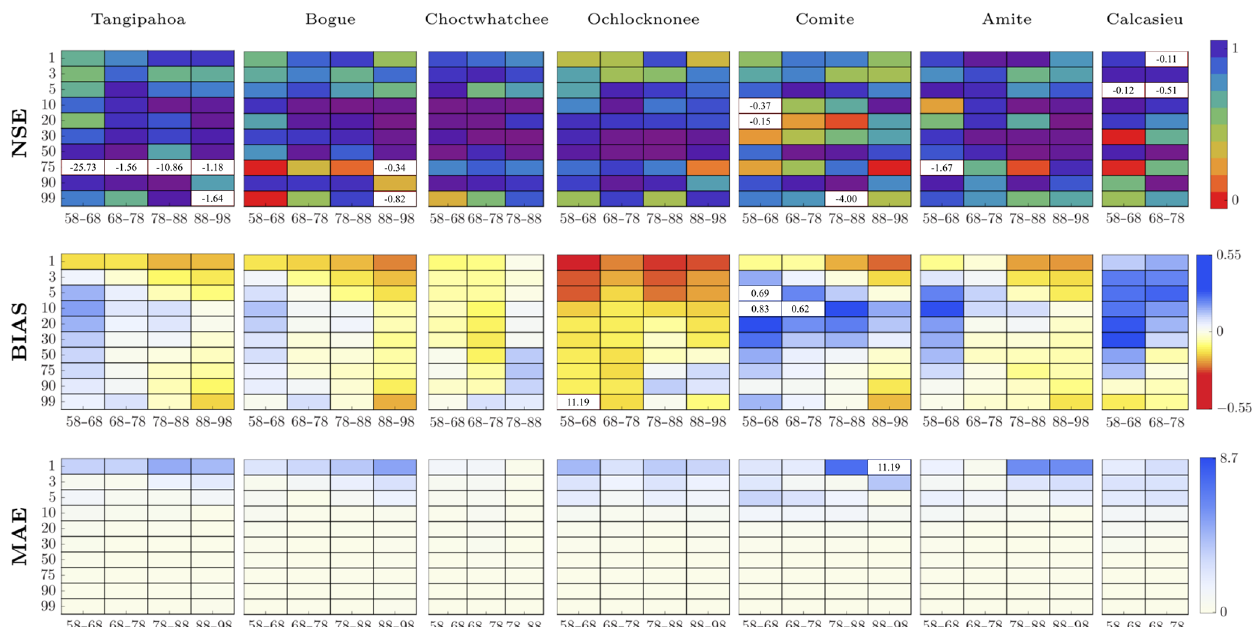
Figure 10. Performance measures NSE, BIAS and MAE evaluated for specific percentiles (on the y axis) and for specific target decades on the x axis. The donor decade is 1948–1958 and the donor basin is Blanco (TX). Each target basin is indicated in the corresponding box. Negative values of the NSE as well as outliers of BIAS and MAE are reported in the corresponding